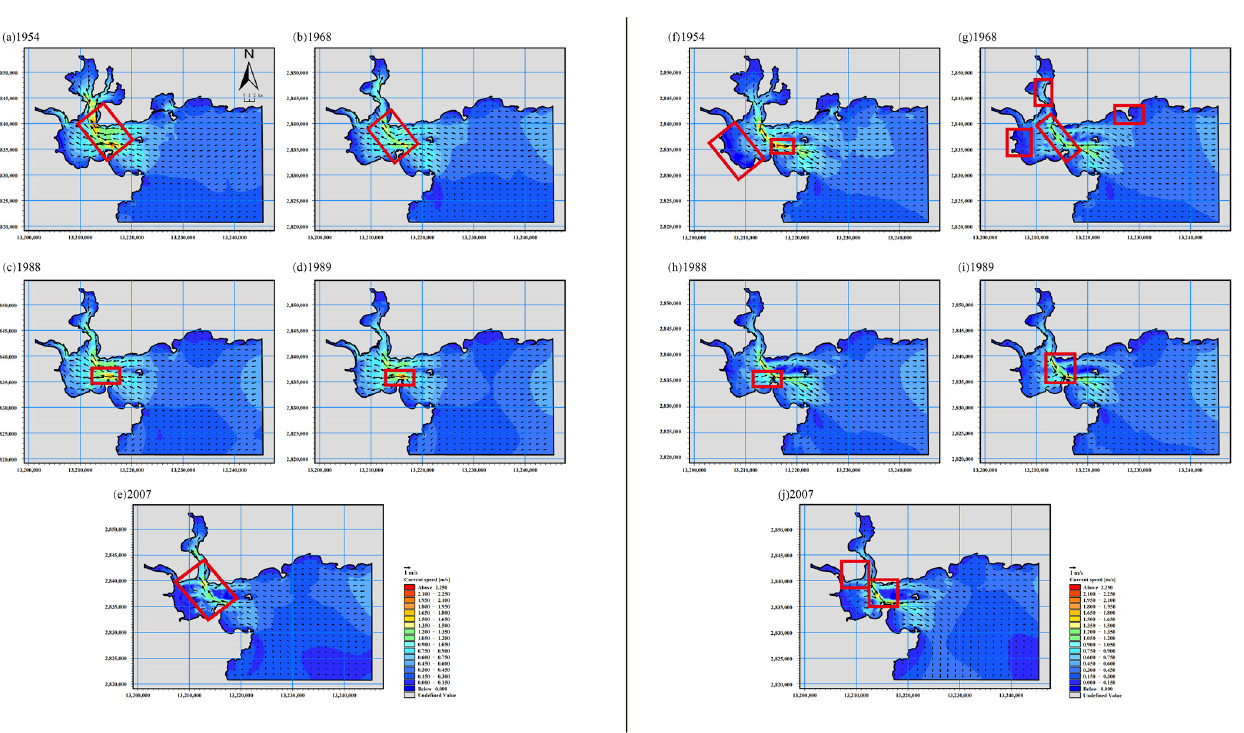
Figure 7. Hydrodynamics changes of Quanzhou Bay caused by coastline change over different periods. ( a – e ) The distribution of hydrodynamic forces during the flood tide in different years after the changes in the coastline. ( f – j ) The distribution of hydrodynamic forces during the flood tide over different years after the changes in the coastline.